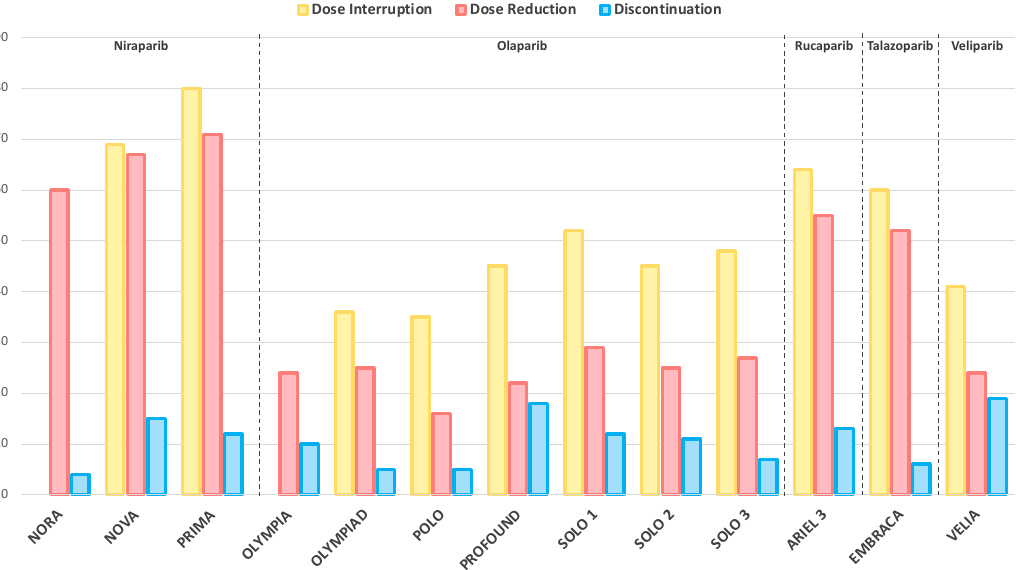
Figure 2. Dose interruptions, reductions and treatment discontinuations of PARP inhibitor monotherapy in phase III randomized trials. The reported dose interruptions, reductions and treatment discontinuations are due to adverse events of any cause, with the exception of NORA and NOVA trials, where they are specifically related to treatment emergent adverse events. Data about dose interruptions are not available for the NORA and OlympiA trials .